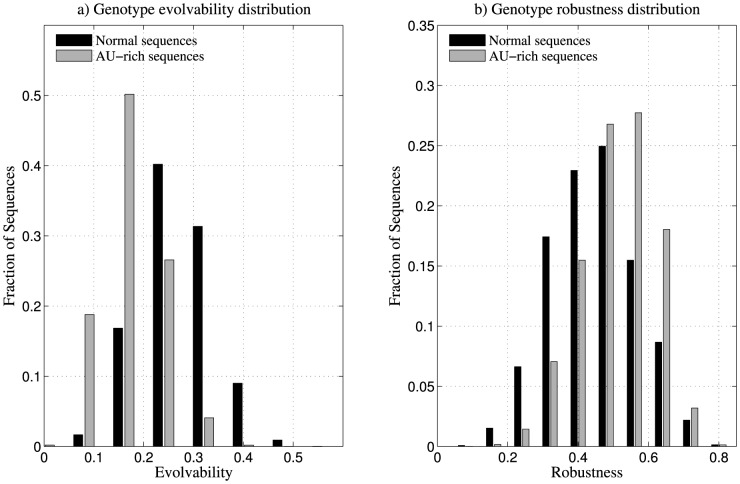
Comparison of genotype robustness and evolvability of normal and AU-rich sequences.(a) Histogram of genotype evolvability of one million normal sequences and one million AU-rich sequences. We observed that a majority of AU-rich sequences have lesser genotype evolvability in comparison to normal sequences. b) Histogram of genotype robustness of one million normal sequences and one million AU-rich sequences. We observed that a majority of AU-rich sequences have higher genotype robustness in comparison to normal sequences. The genotype space is weighted using κ = 2.5.